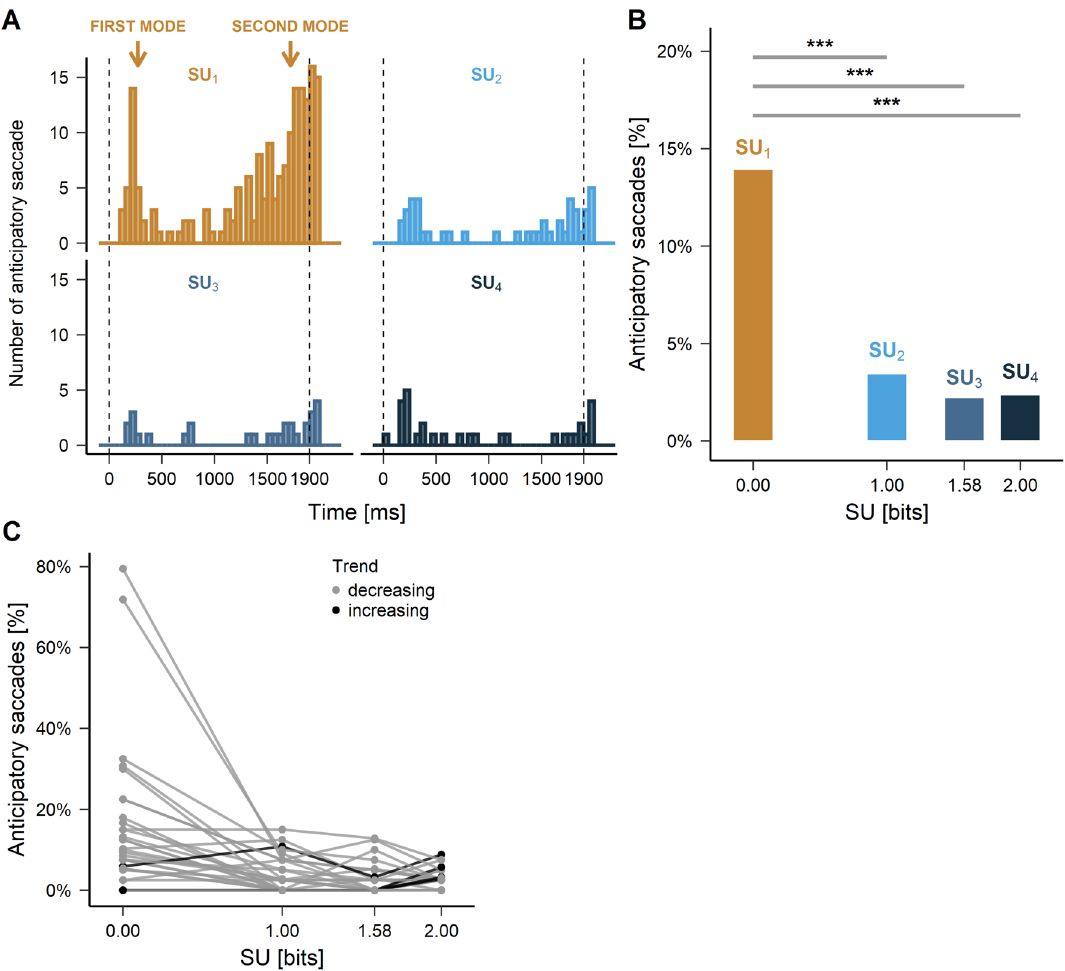
Figure 4. ( A ) Latency distributions of anticipatory saccades for the different SUs tested. Time ‘zero’ on the X-axis indicates FP onset. In the absence of surprise about the future target position, a bimodal distribution of latencies was clearly observed. ( B ) Bar plot of the percentage of anticipatory saccades during the FP. Horizontal grey lines indicate GLMM significance level between conditions. ( C ) Percentage of anticipatory saccades during the FP for each SU and each subject. Black lines show subject with an increasing number of anticipatory saccades with increasing SU (opposite trend). The trend was calculated as the difference between SU 1 and SU 4 conditions.